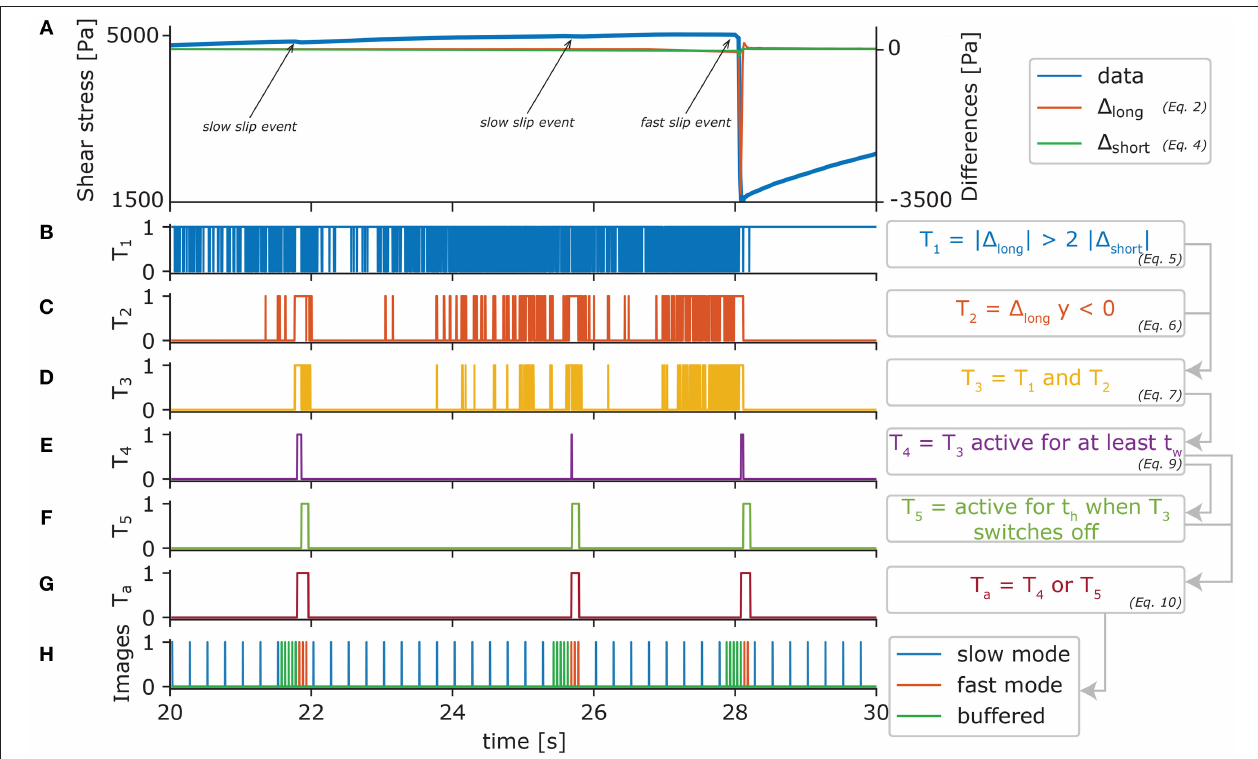
FIGURE 4 | Behavior of the trigger algorithm during an experiment. Input parameters are: t w = 30 ms , t h = 100 ms , polarity is negative, F high = 20 Hz , n = 5, i = 5. (A) Typical shear curve of an experiment. The data contains very fast slip events and slower slip events. The latter are very difficult to detect by eye. (B–G) Individual results of the trigger conditions, with successively increasing accuracy. (H) Images taken during the experiment, distinguished by low, fast, and buffer